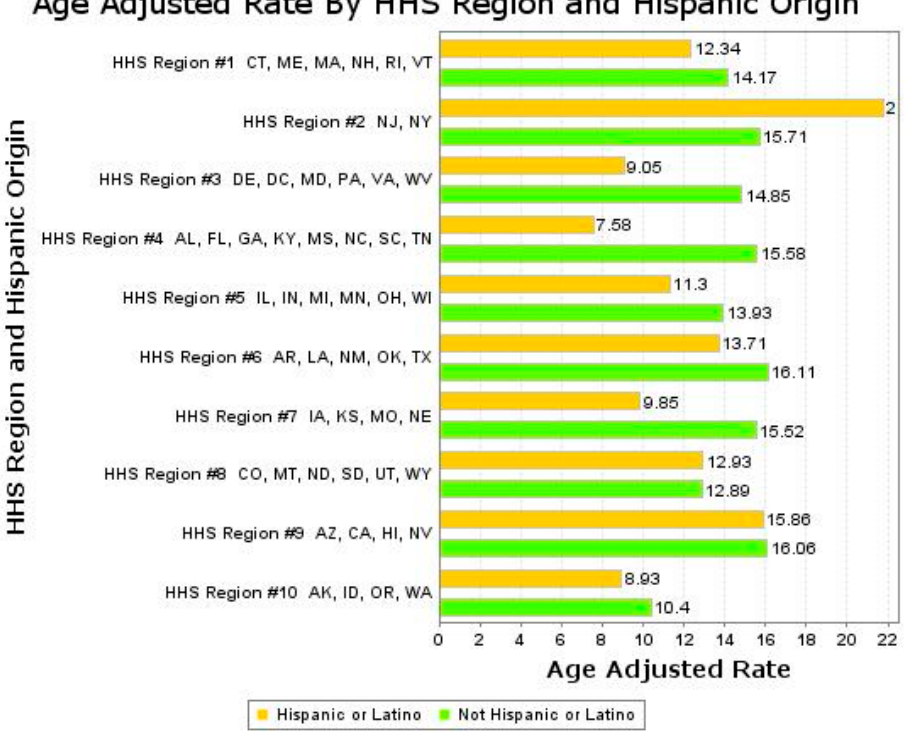
Figure 2. Age-adjusted mortality rate for influenza/pneumonia by Hispanic origin and HHS Region. X-axis units are deaths per 100,000.